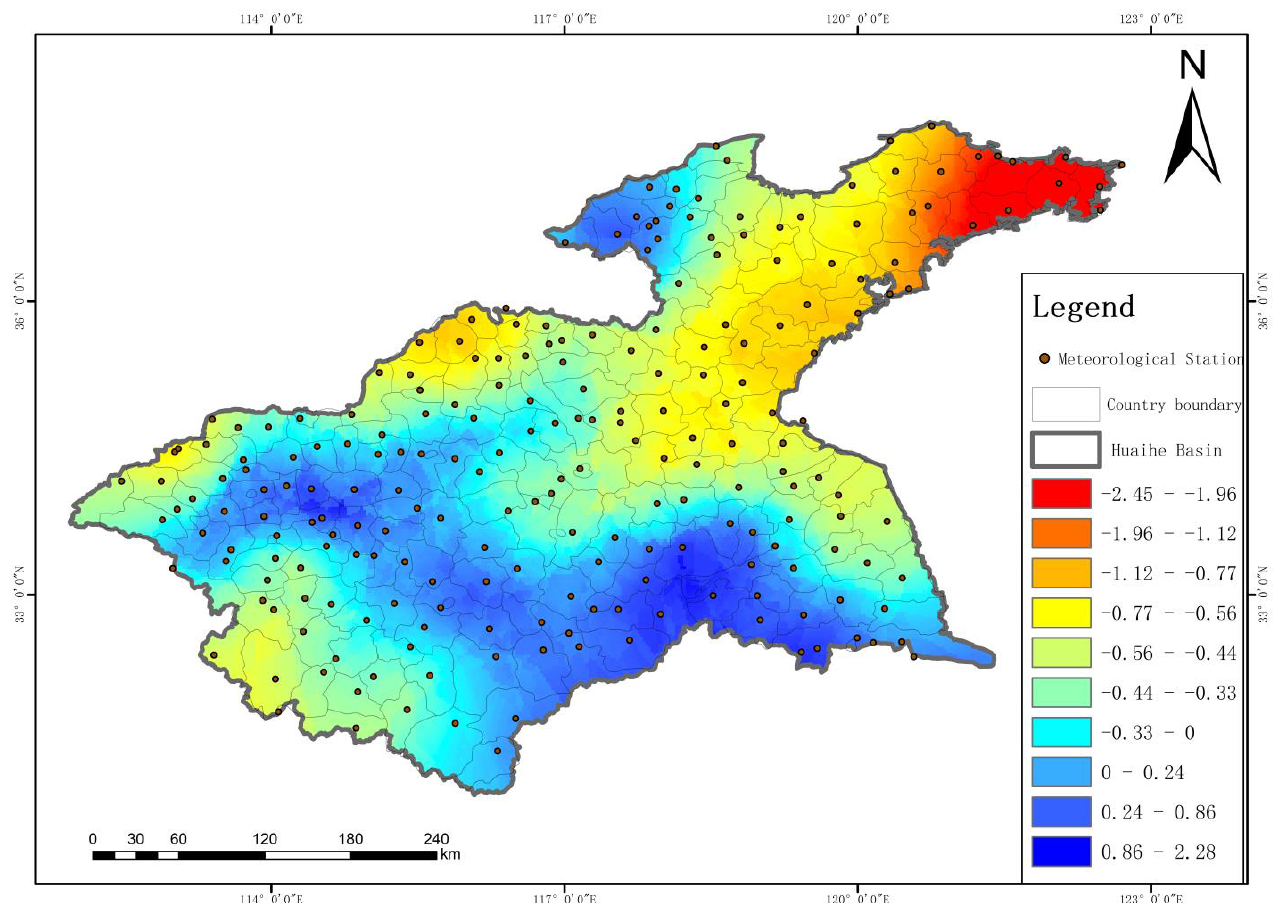
Figure 5. Spatial distribution of Z-values of annual precipitation.